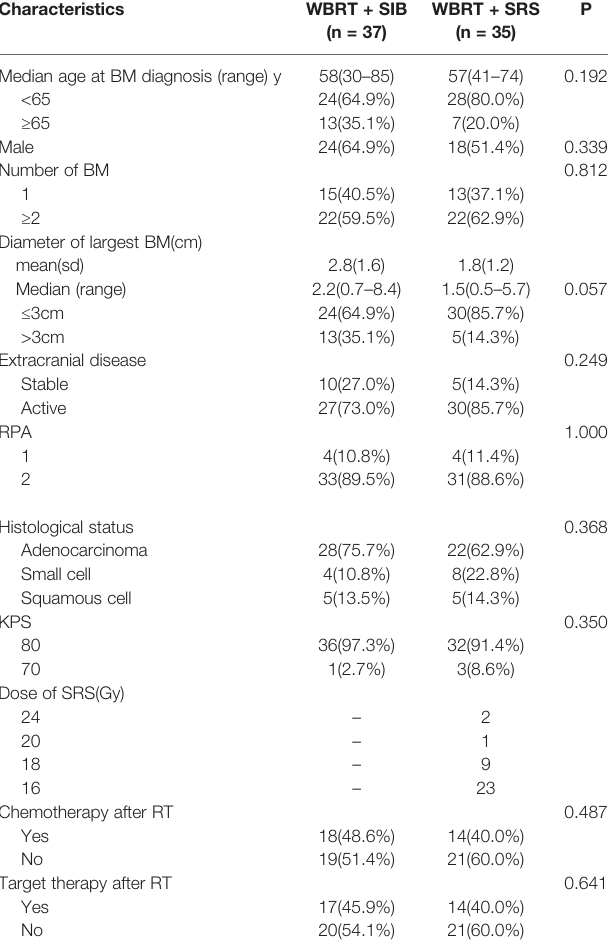
TABLE 1 | Patients characteristics.